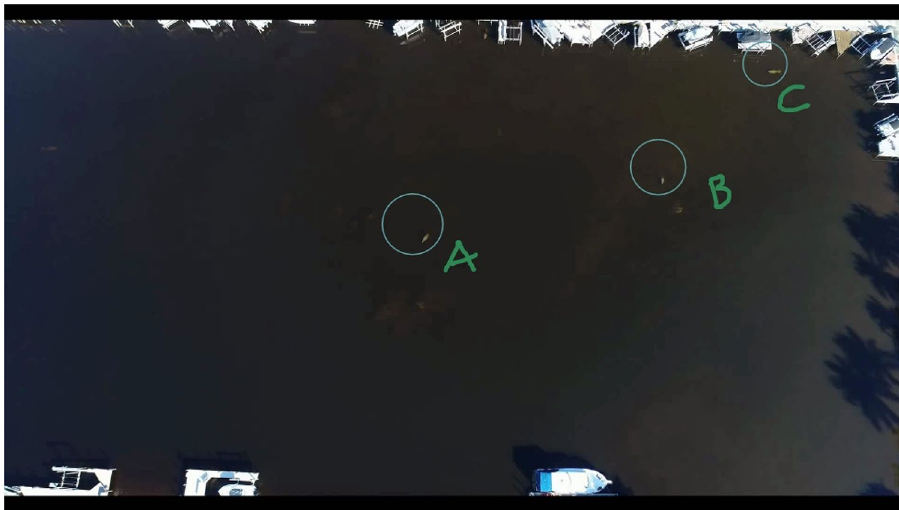
Figure 3. Example of manatees identified using the Kinovea software to create a sighting history for 1 min of